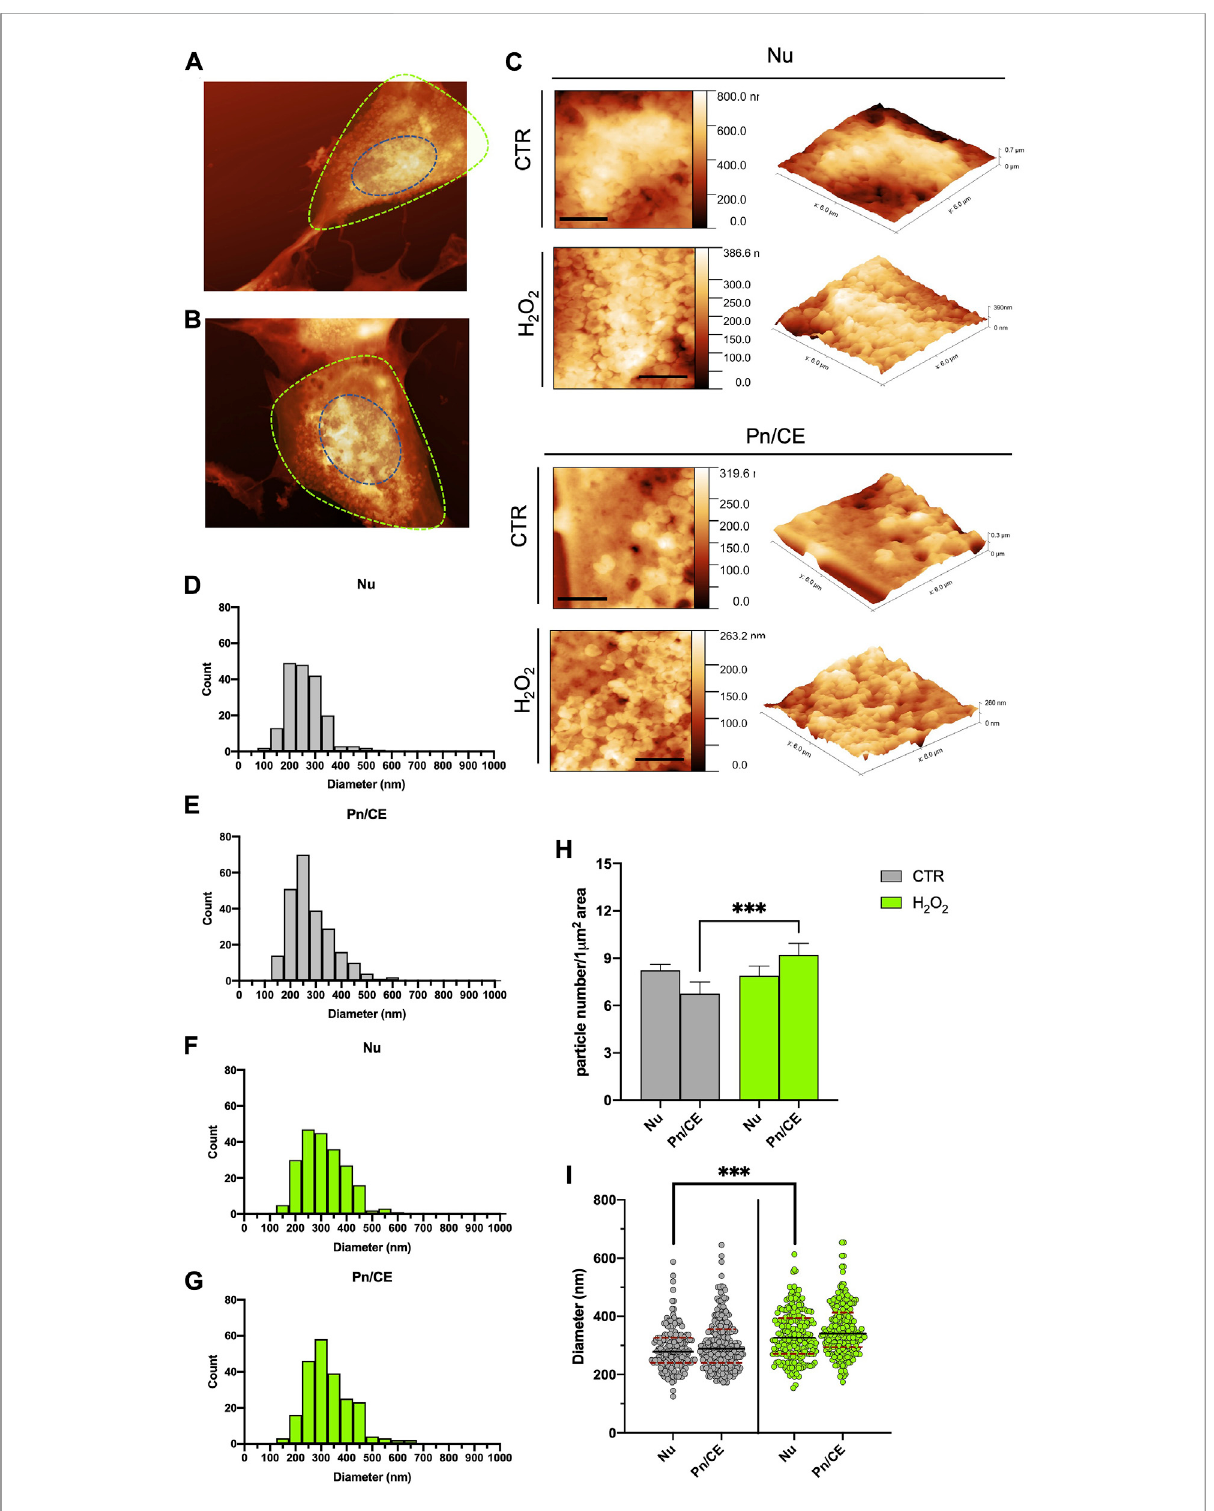
FIGURE 3 Statisticalanalysisofthespatialdistributionofthebuddingvesiclesonthecells,asseenwithAFM. (A) and (B) exampleofthesegmentationofthe AFM images in nuclear (Nu, blue dotted line) and perinuclear (Pn/CE, green dotted line) for one control (A) and one H2O2 treated (B) cell. (C) typical highresolution2D(left,scalebars2 µm)and3D(right)zoomofa6×6micronareasofthecontrolandH2O2treatedcellsintheNuclear(toppanels) and perinuclear (bottom panels) used for the manual counting and diameter measurements of the vesicles. (D) to (G) size distributions of the